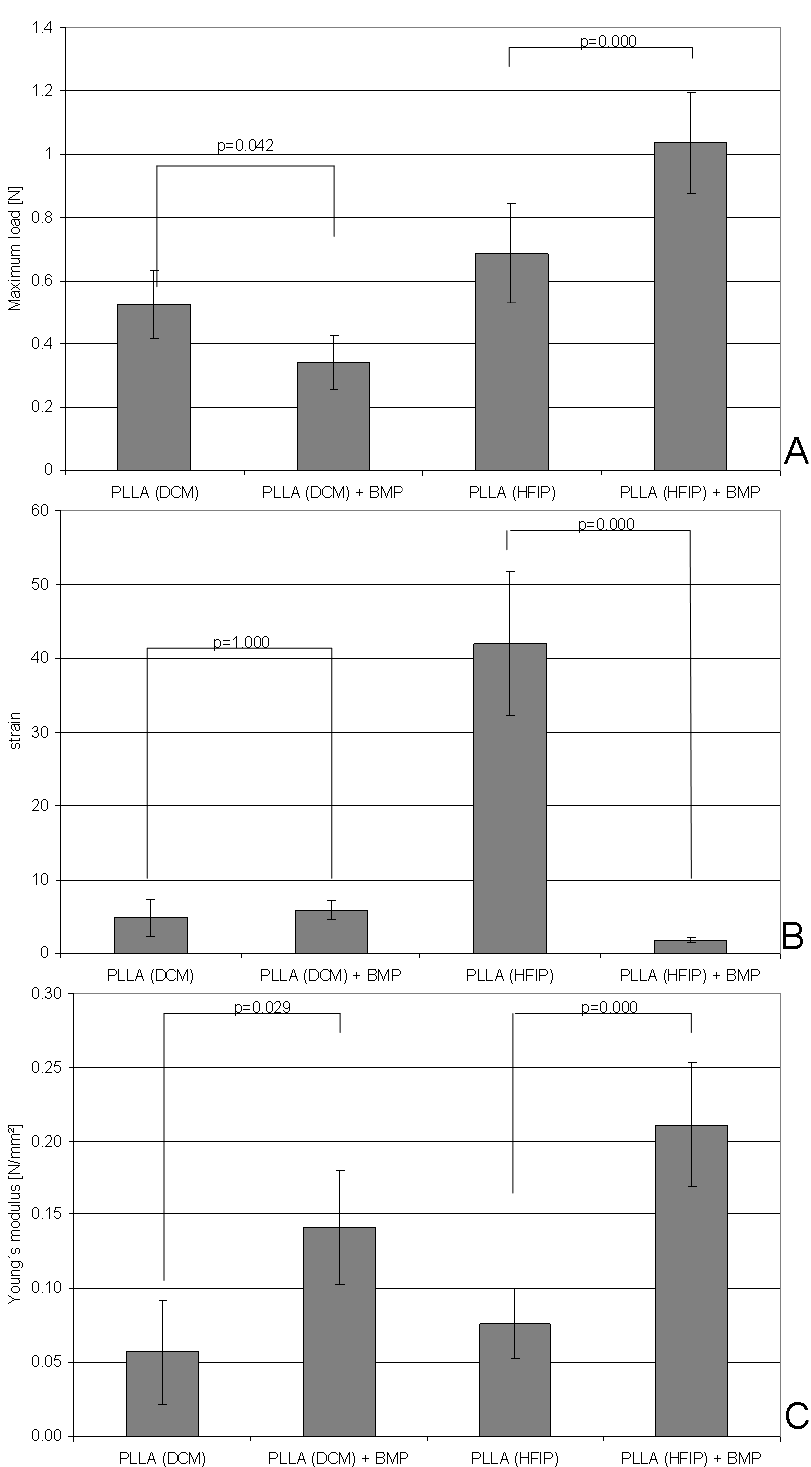
FIGURE 3. Influence of the incorporation of BMP into PLLA on maximum load (A), strain (B), and Young’s modulus